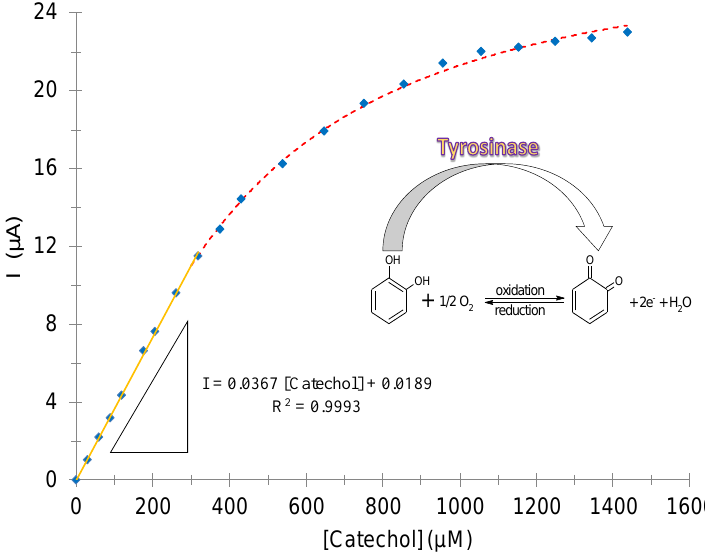
Figure 3. Enzymatic kinetics for catechol using mushroom tyrosinase in solution, in 0.1 M acetates’ buffer at pH 4.50 ± 0.01 and at (30.0 ± 0.5) °C. Following the measured current at –300 mV imposed potential as a function of the catechol’s concentration. The dots are experimental data and the line is the fitting of the Hill’s model of Equation (1), the best fit parameters were Km = (0.40 ± 0.01) mM, I = (27.5 ± 0.4) μA and h = 1.35 ± 0.03. The max inset shows the reaction scheme of catechol and benzoquinone catalyzed by